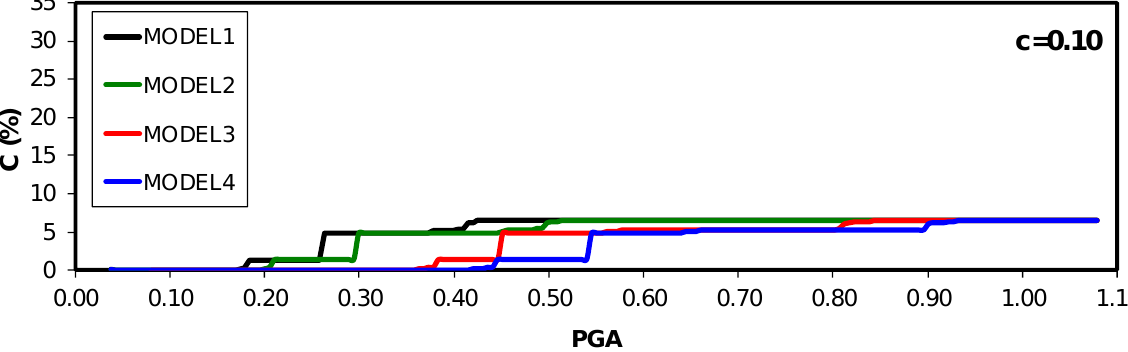
Figure 5. Indirect losses due to connectivity losses (C). Scenario 1: c=0.10.